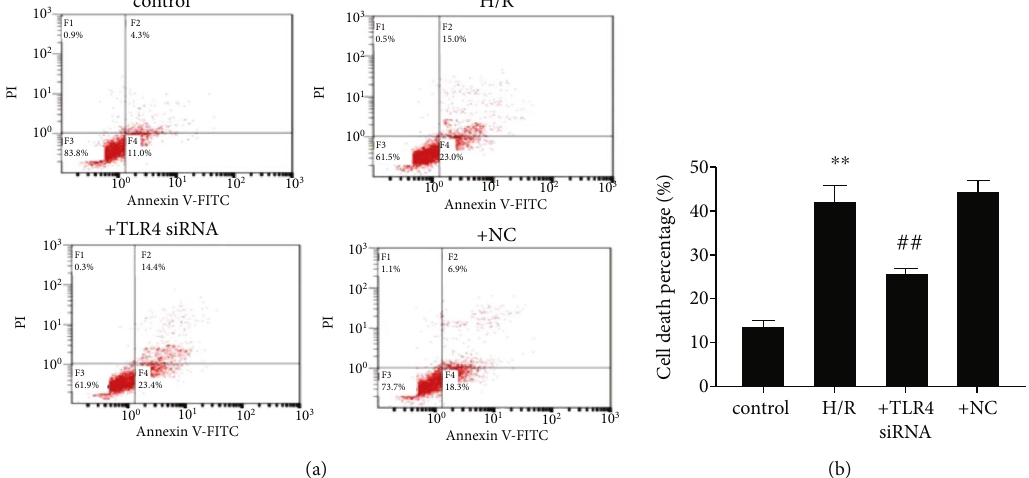
Figure 6: (a) TLR4 knockdown reduces increases in cell apoptosis in H/R-induced SH-SY5Y cells. Representative images of fl ow cytometry. (b) Cell death percentage. The data expressed as mean ± SD . ∗∗ P < 0 : 01 vs. control; ## P < 0 : 01 vs.